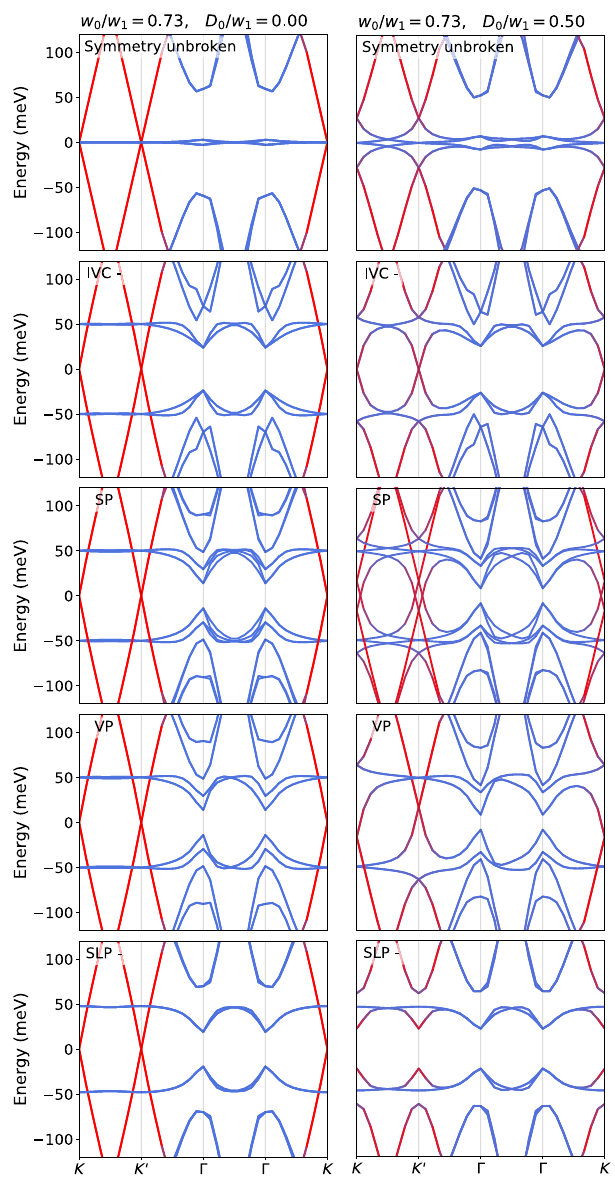
FIG. 3. HF band structures in the limit D 0 ¼ 0 (left) and nonzero D 0 (right) as obtained from Eq. (4.1) for the optimal P k in the respective symmetry-breaking channel defined in Table II. We show only the states which are either ground states or subleading energy states for some region of our phase diagram, with a full set of band structures available in the Supplemental Material [59] Sec. C 3. Each band of the HF Hamiltonian is colored according to the expectation value of the mirror-sym- metry operator within each band as a function of k , with the expectation value ranging from − 1 (red) to þ 1